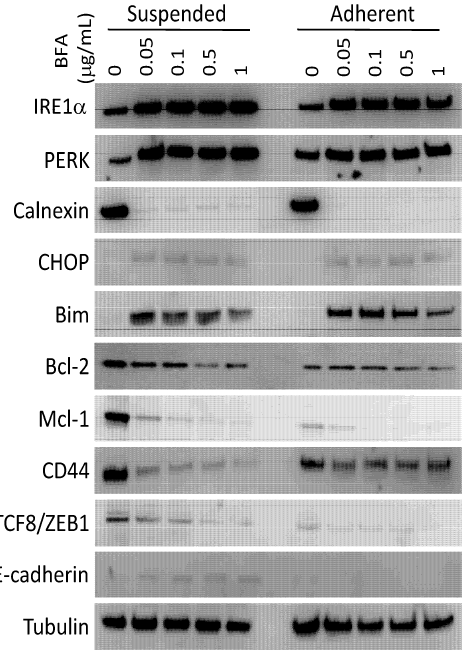
Figure 4. Modulation of protein expression by BFA. The total cell lysates of suspended or adherent MDA-MB-231 cells treated with 0–1 μ g/mL for 24 h were analyzed by western and CHOP), the BCL family apoptosis regulators (Bim, Bcl-2 and Mcl-1), proteins involved in epithelial-mesenchymal transition (TCF8/ZEB1 and E-cadherin), and